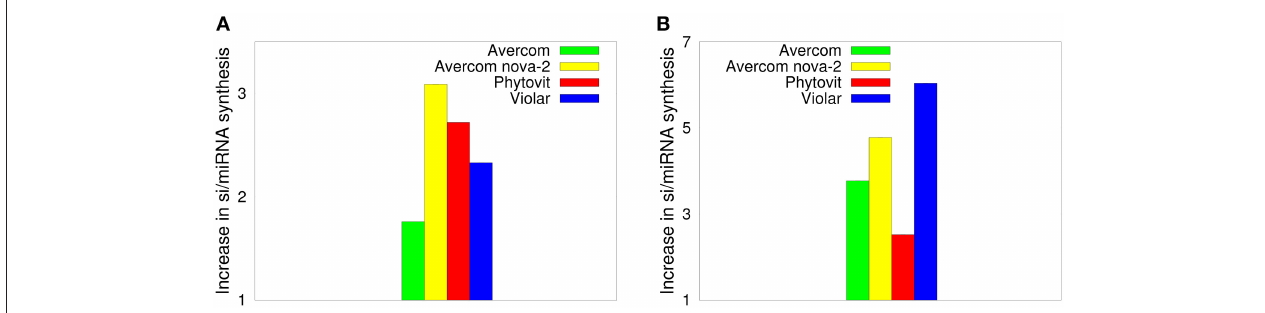
FIGURE 3 | Effects of biostimulants on increasing the synthesis of si/miRNA in nematode-infested plants grown using biostimulants in planta that are complementary with mRNA from control plants (A) , and with nematode mRNA (B) , scaled by the amount of si/miRNA isolated from nematode-infested plants grown under the same conditions but without the use of biostimulants. The error bars are not visible, since they are three orders of magnitude smaller than the reported values.